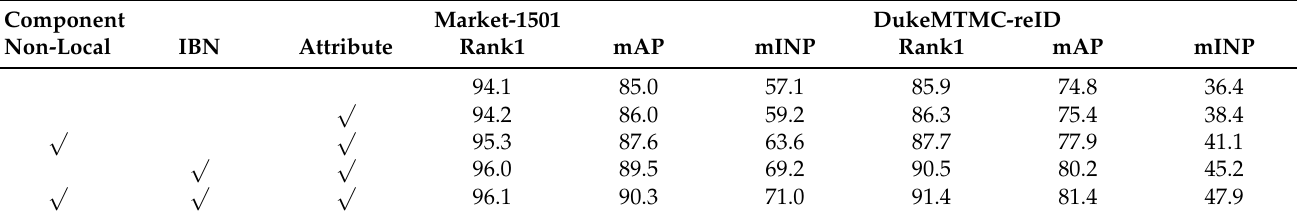
Table 4. Results of ablation